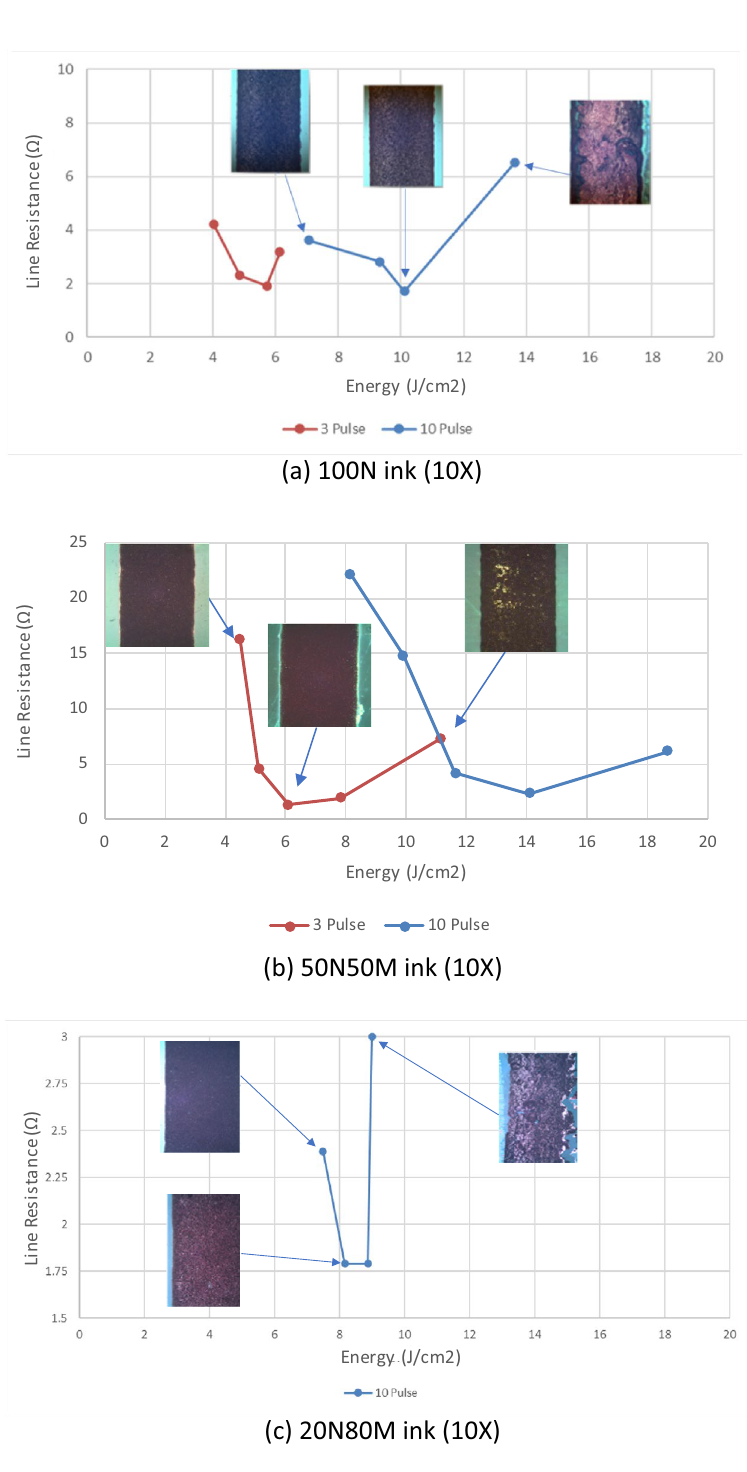
Figure 4. Sintering envelopes for the three inks defined by the resistance of the 600 µm wide line.